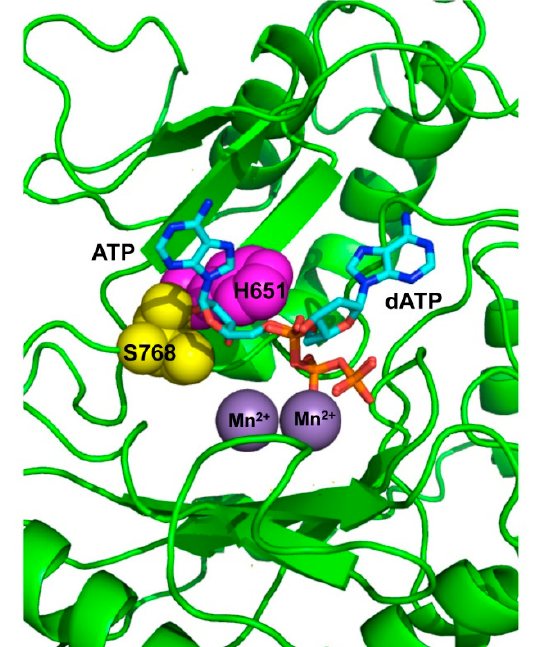
Figure A1. Detailed view of the conformations adopted by ATP and dATP at the catalytic site of Pa -PolDom. Figure was done by overlapping the structures of the Pa -PolDom/ATP (PDB 2FAQ; [31]) and Pa -PolDom/dATP (PDB 2FAQ; [31]) complexes. 2 ′ -OH contacting residues His651 and Ser768 studied here are represented as magenta and yellow spheres. See main text for details.